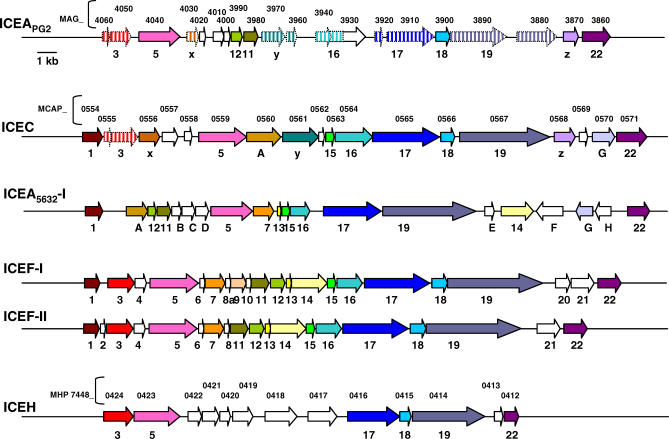
Genomic Organization of ICEs and ICE-Related Genes in MollicutesArrows represent CDSs, hatched arrows represent pseudogenes. Homologous CDSs are identified by the same colour and same number or letter underneath. Numbering is using the nomenclature of M. fermentans ICEs (ICEFI and II) as a reference [15], whereas letters refer to the CDSs without any ortholog in ICEF. Locus tags for genes from the ICEs of M. agalactiae strain PG2, M. capricolum subsp. capricolum strain California Kid, and M. hyopneumoniae strain 7448 (MAG_4060–3860, MCAP_0554–0571, and MHP7448_424– 412, respectively) are indicated above the arrows. Other ICE-related genes present in M. hyopneumoniae strain 232, M. pulmonis, M. mycoides subsp. mycoides SC, and S. citri are not shown on the figure. ICEAPG2
, ICE of M. agalactiae strain PG2; ICEC, ICE of M. capricolum subsp. capricolum strain California Kid; ICEA5632-I, ICE of M. agalactiae strain 5632; ICEH7448, ICE of M. hyopneumoniae strain 7448; and ICEH232, ICE of M. hyopneumoniae strain 232.